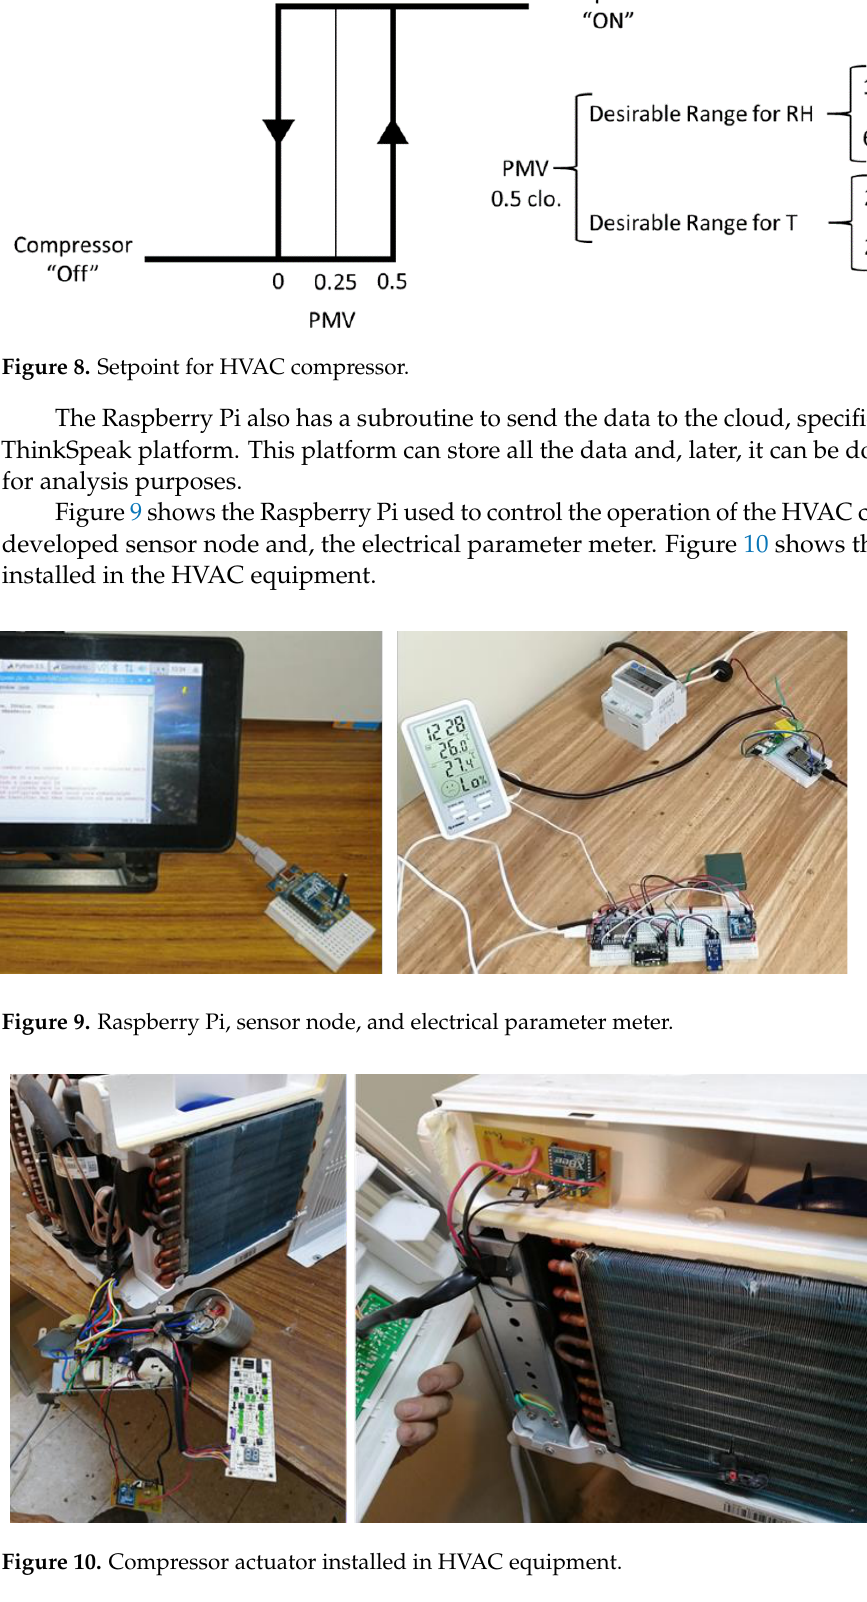
Figure 10. Compressor actuator installed in HVAC equipment.